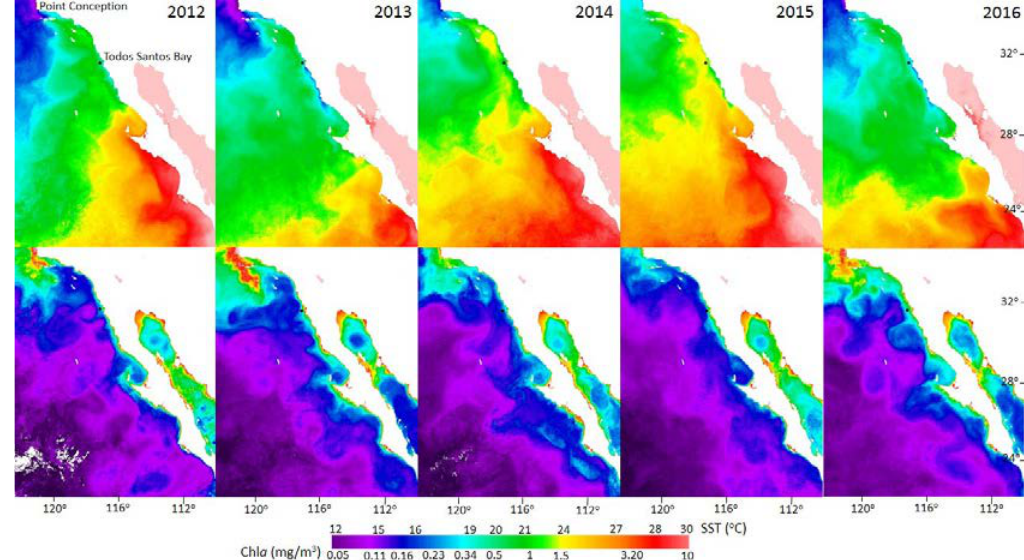
Figure 5. Monthly composites of SST (upper panel) and Chla SAT (lower panel) for the month of September from 2012 to 2016. The black dot indicates the location of our study site. The color palette is shown below.